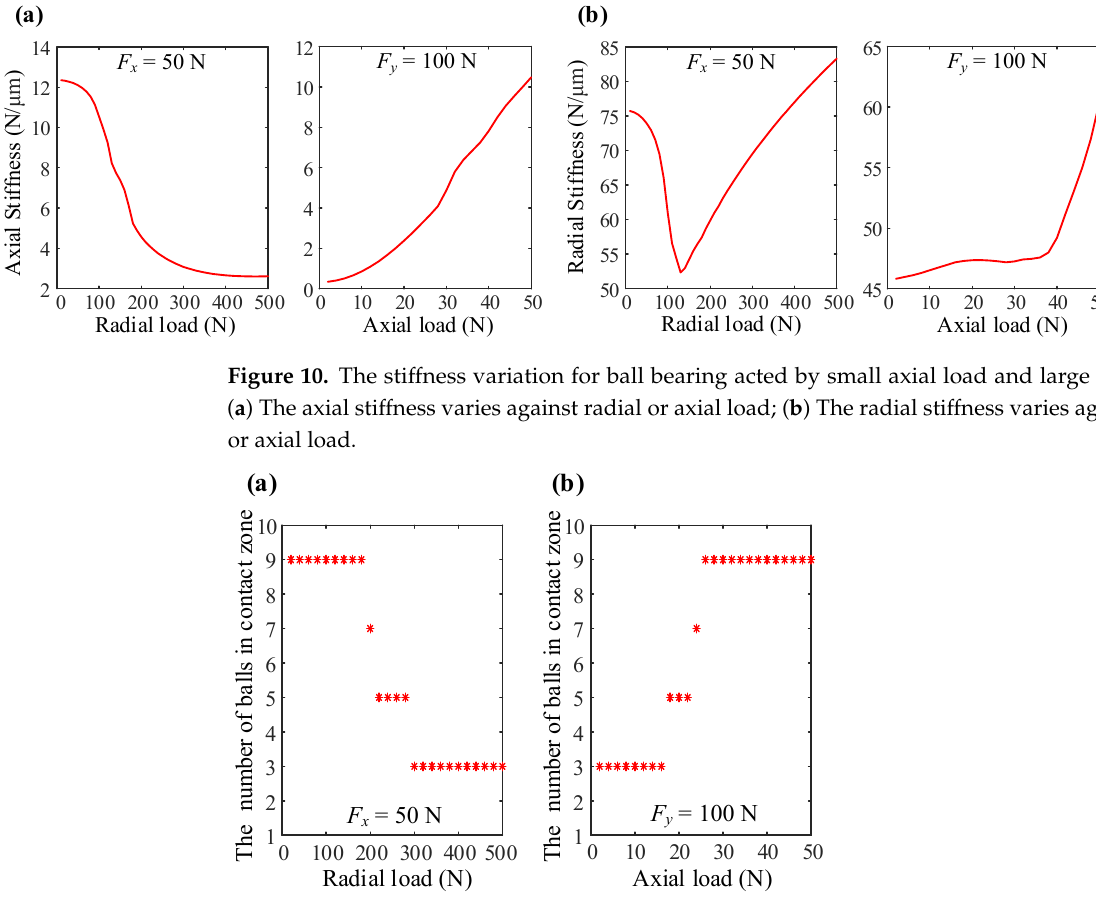
Figure 11. The contact states between balls and raceways for ball bearing acted by the small axial load and large radial load: ( a ) the contact states between balls and raceways varies with axial force; ( b ) the contact states between balls and raceways varies with radial force.